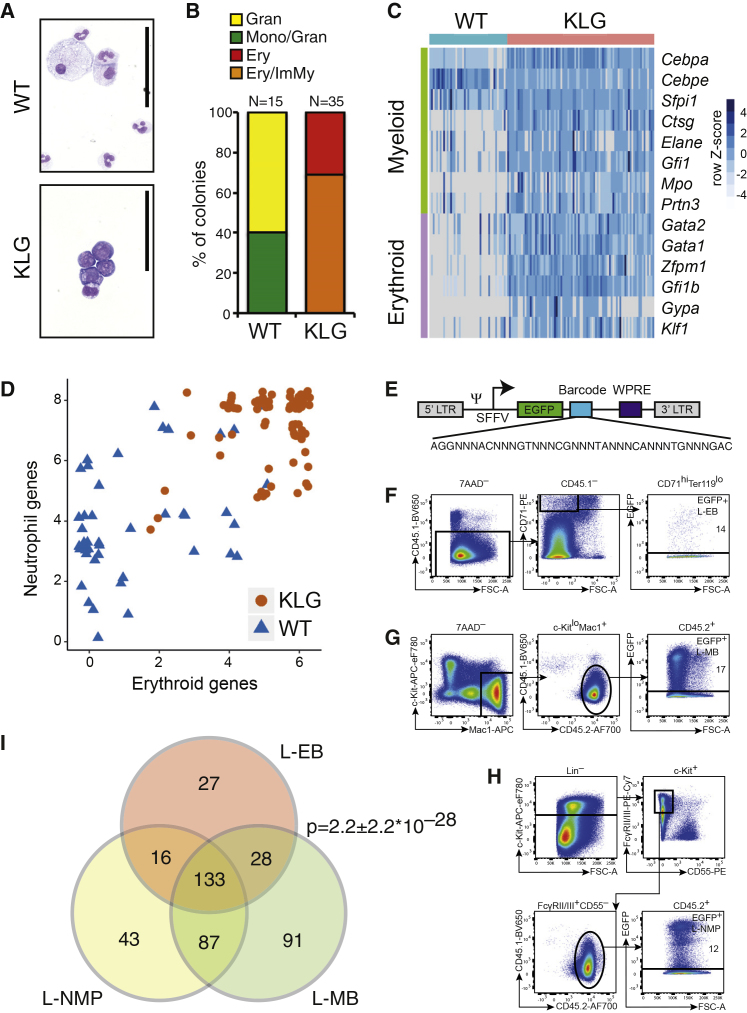
AEL LICs Are Bipotent at the Single-Cell Level(A) Cytospins of single NMP colonies stained with May-Grünwald and Giemsa. Scale bars, 50 μm.(B) The morphology of colonies generated from single WT and KLG NMPs is shown. Gran, granulocytic; Mono, monocytic; Ery, erythroid; ImMy, immature myeloid. The total number of colonies scored for each genotype is indicated.(C) Multiplex qRT-PCR of myeloid and erythroid genes on colonies derived from single NMPs. WT, n = 45; KLG, n = 85. The heatmap shows 2–ΔCt values normalized to the average of Gapdh and Hprt and centered on the mean value for each gene.(D) Scatterplot depicting the number of myeloid and erythroid genes co-expressed in individual WT and KLG colonies from (C).(E) Schematic of the lentiviral barcoded library vector.(F) Sorting strategy for re-isolation EGFP+ L-EBs from mice transplanted with barcoded KLG-E L-NMPs. Data representative of three independent transplantation experiments are shown. Percentages of re-isolated transduced cells are indicated.(G) Sorting strategy for re-isolation of EGFP+ L-MBs as in (F).(H) Sorting strategy for re-isolation of EGFP+ L-NMPs as in (F).(I) Venn diagram depicting the overlap of barcodes retrieved from the populations isolated above (F–H). Data are representative of three independent transplantation experiments. Mean p value ± SD of three independent transplantations is shown (hypergeometric test).